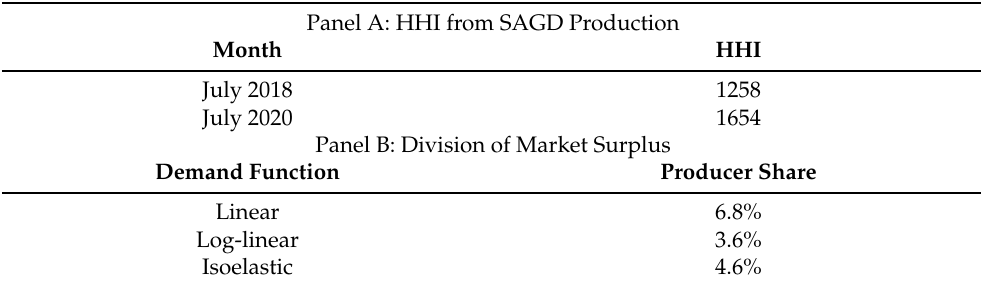
Table 8. Increase in the Share of Producer Surplus due to Consolidation.